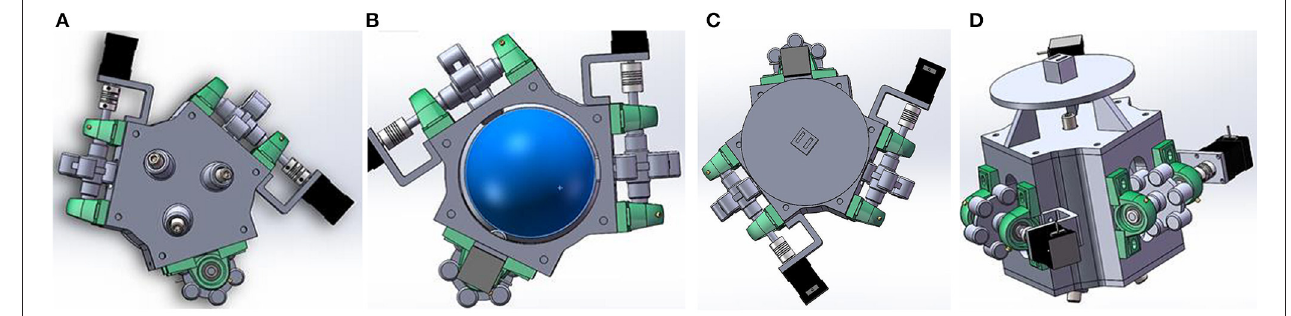
FIGURE 8 | (A) Top view of upper cover; (B) Cross-section of main structure; (C) Bottom view of lower cover; (D) 3D structure of